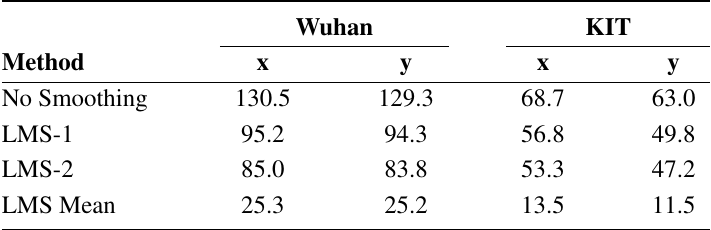
Table 1. θ of motion field estimation (MFE) with various smoothing algorithms (unit: cm/s). Wuhan KIT